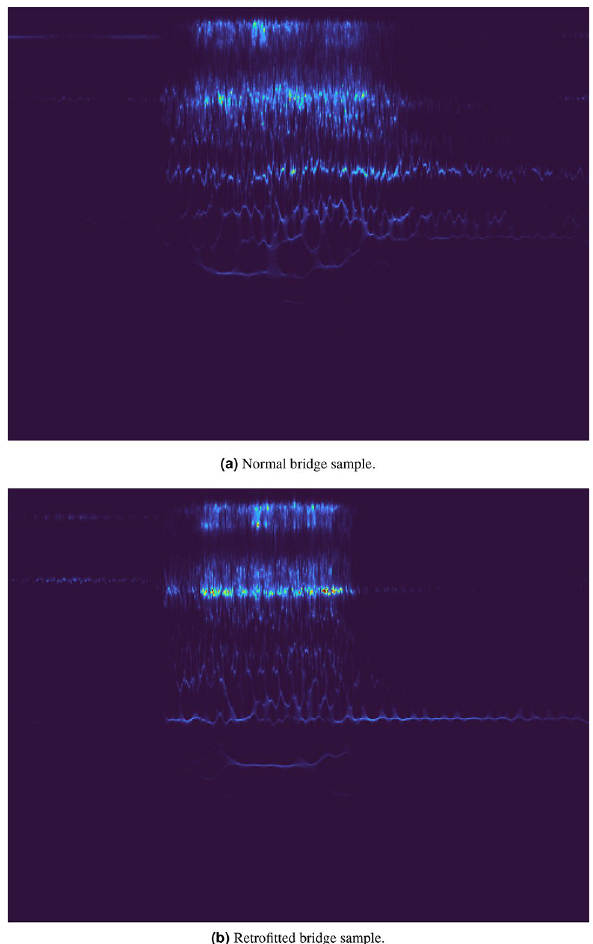
Figure 1. Example of images produced by applying the SCWT function on two samples, followed by the application of turbo colormap function. ( a ) Image refers to a normal bridge sample, while ( b ) refers to a retrofitted bridge sample.